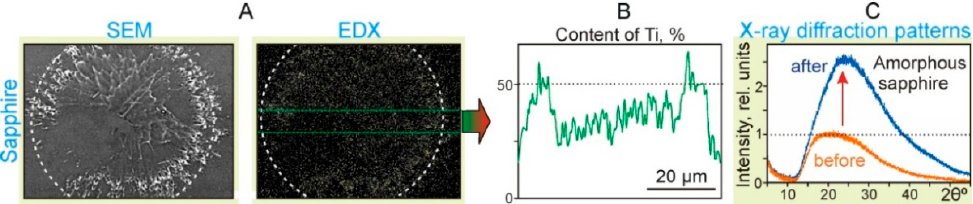
Figure 6. Results of the action of single laser pulses with the energy E = 19.5 mJ and laser fluence F = 2.8 J/cm 2 on the sapphire acceptor plate placed in close contact with the Ti film on the donor slide. ( A ) SEM images (SEM) and surface distribution maps of Ti particles (EDX). The dotted circles denote an area with a diameter of 54 μ m. ( B ) The surface distribution map of Ti particles. ( C ) X-ray diffraction patterns of the sapphire surface inside the dotted circle before and after the laser pulse expo- sure.